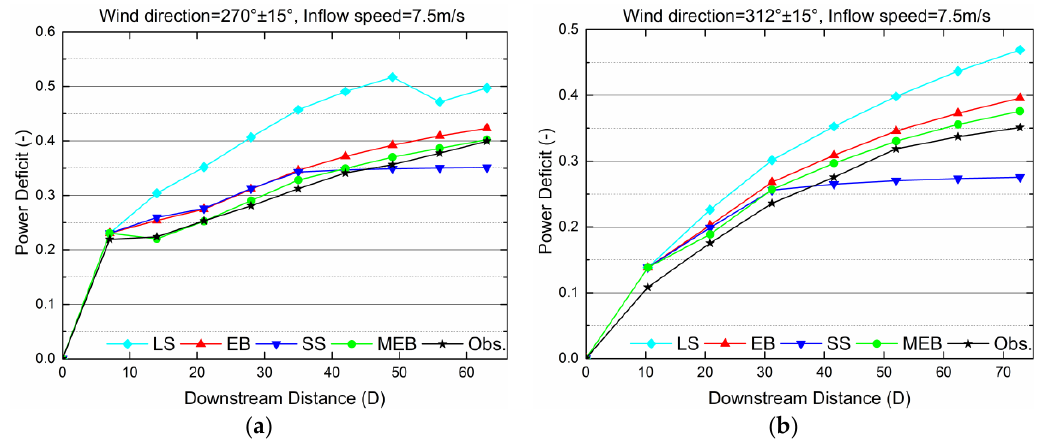
Figure 9. Horns Rev I power deficit in ( a ) a row with 7D spacing and 270 ± 15°, and ( b ) a row with 10.4D spacing and 312 ±